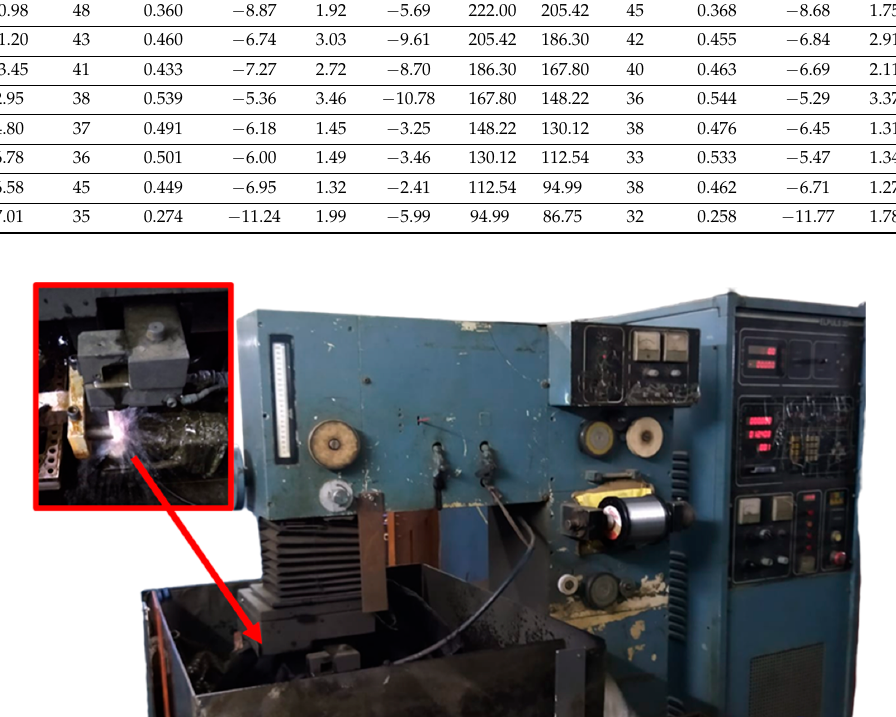
Table 1. Process parameters and their levels.